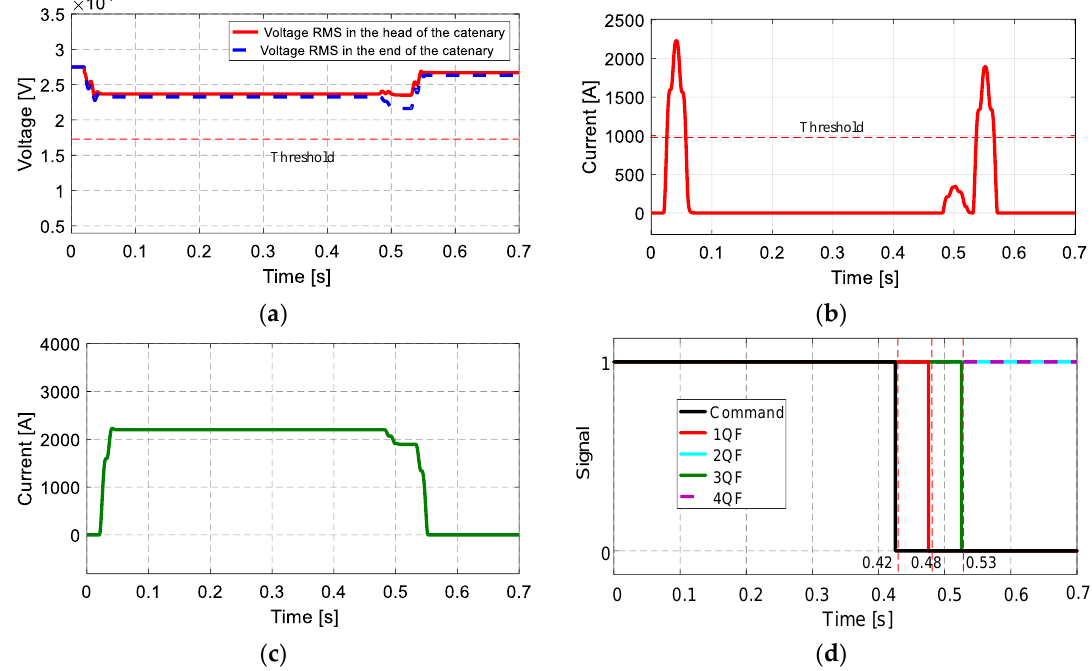
Figure 15. Catenary voltage RMS, operation increment current, operation current, and signals in C-G short-circuit at the AT subsection 1: ( a ) Catenary voltage RMS in the TS and ATS; ( b ) operation increment current in the catenary; ( c ) operation current in the catenary; and ( d ) signals of the command and the circuit breakers.